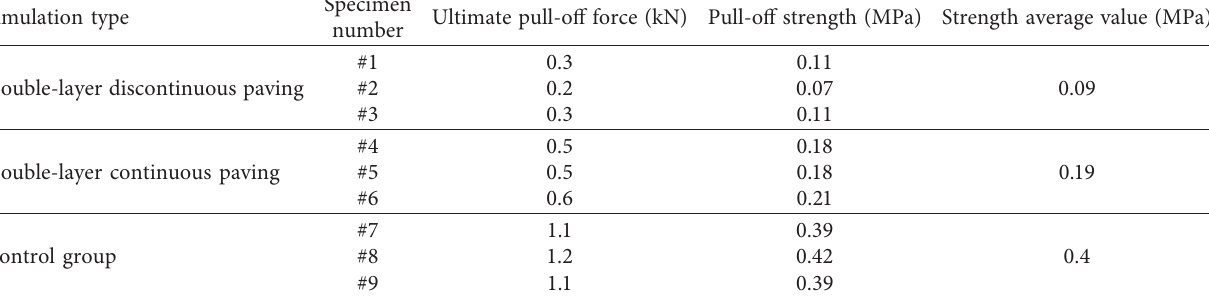
Table 3: Pull test results of interlayer bonding.